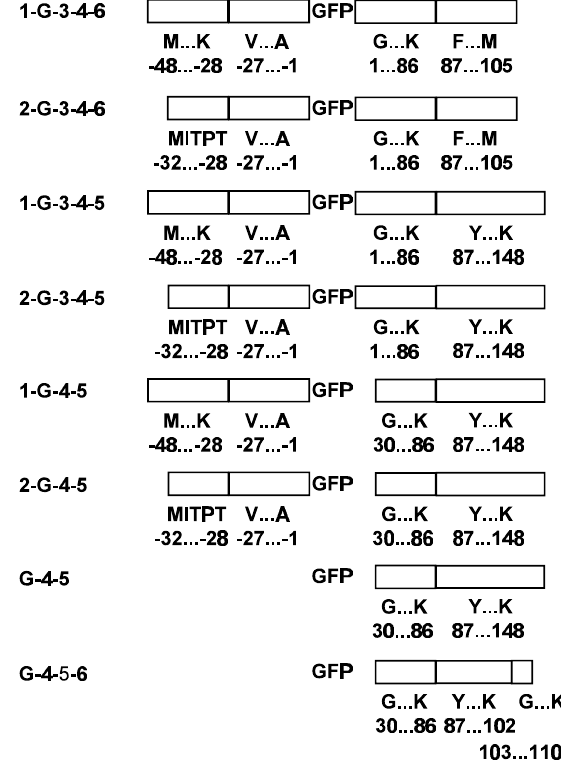
Figure 2 GFP-IGF-I chimeras. The designations of the chimeras are on the left, while the domain structures of the chimeras are shown only approximately to scale. The first and last amino acid residue of each domain is given underneath, while the numbers are the coordinates relative to the first residue of the mature IGF-I peptide, a